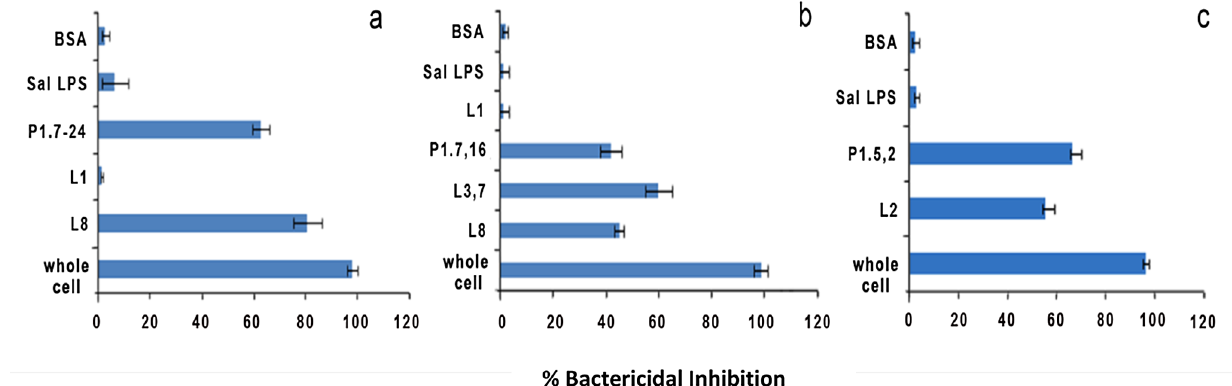
Figure 5. Characterization antibody specificity by the bactericidal Inhibition assay. Pooled sera from mice immunized with the NOMV vaccine was analyzed for bactericidal antibody specificity using N. meningitidis wild type vaccine strains as the target strain in a bactericidal depletion assay. In Fig. 5a the bactericidal target strain used was wild type NZ9547, in Fig. 5b the bactericidal target strain used was wild type H44/76, and in Fig. 5c the bactericidal target strain used was wild type B16B6. The antigens used to for depletion are shown in the